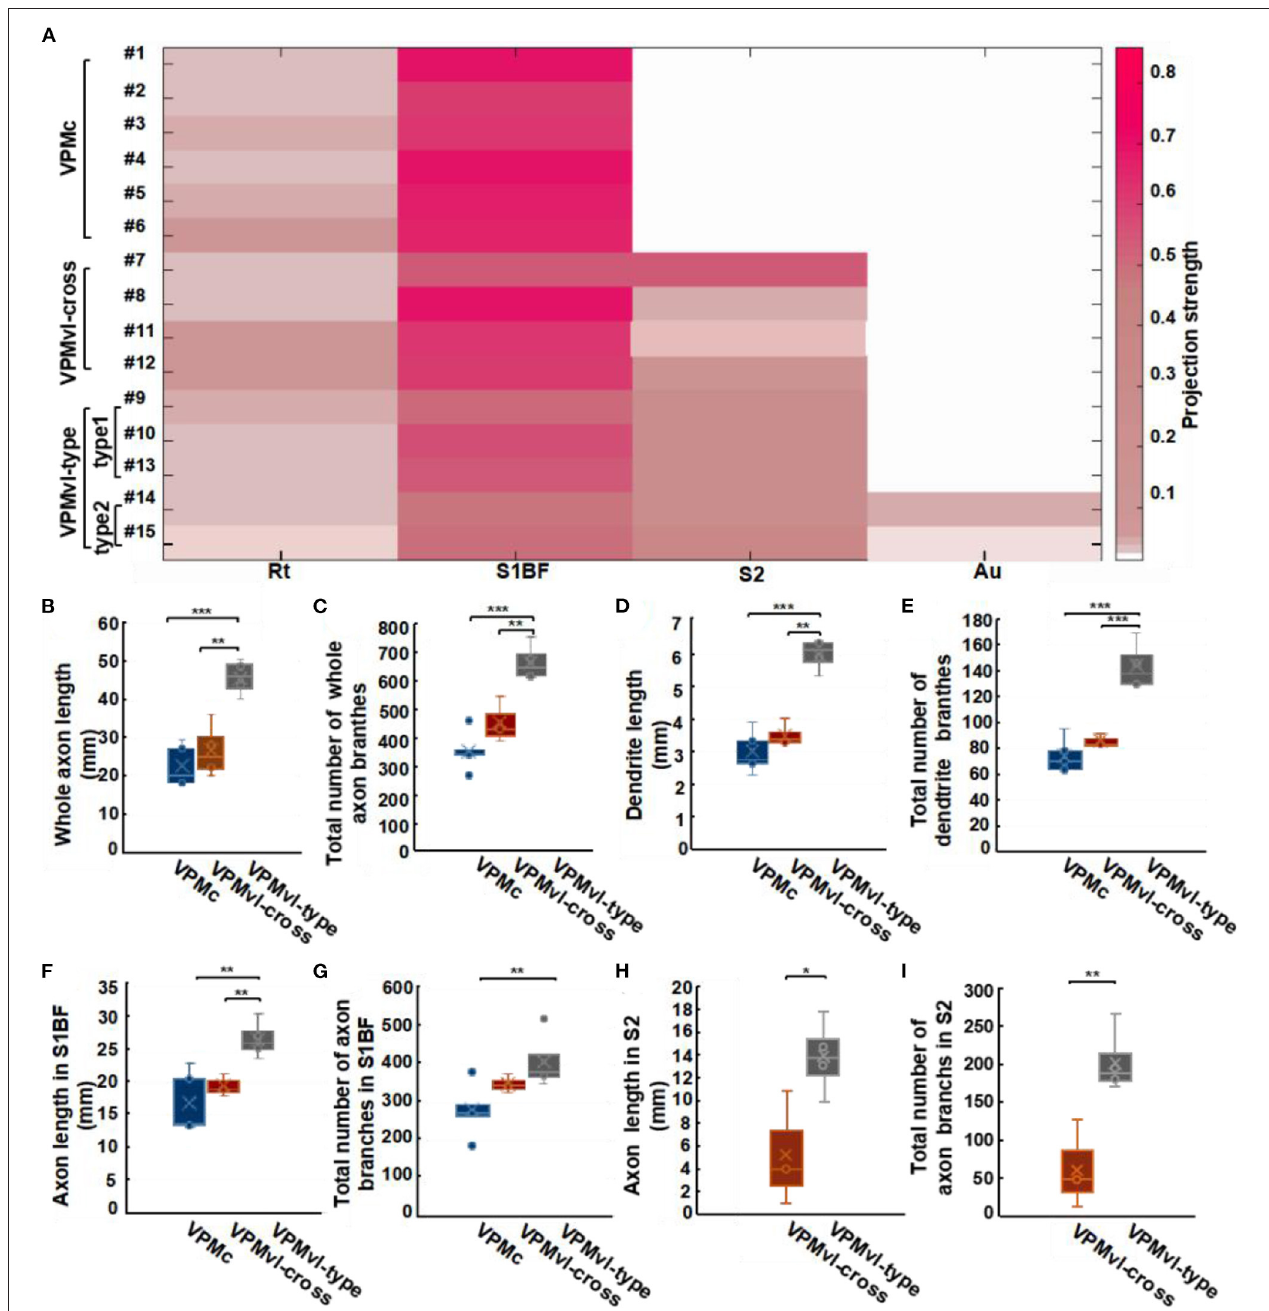
FIGURE 5 | Characteristic analysis of three VPM subgroups in different areas. (A) Projection strengths in different regions in target areas for each VPM neuron. Comparisons of whole axonal length (B) and the total number of axonal branches (C) among VPMc, VPMvl-cross, and VPMvl-type. Comparisons of dendritic length (D) and the total number of dendritic branches (E) . Comparisons of axon length in S1BF (F) and the total number of axon branches in S1BF (G) . Comparisons of axon length in S2 (H) , the total number of axon branches in S2 (I) between the VPMvl-cross and the VPMvl-type. VPMc: n = 6; VPMvl-cross: n = 4; VPMvl-type (VPMvl-type1 and VPMvl-type2): n = 4. * p < 0.05, ** p < 0.01, *** p < 0.001, n.s. Represents no significant correlations.